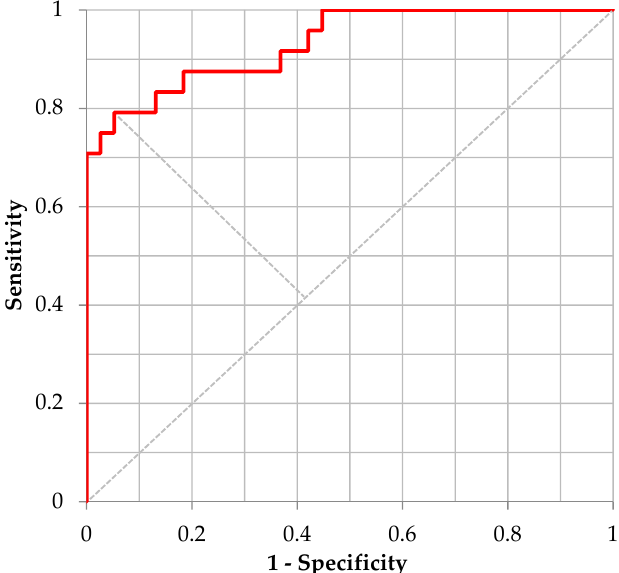
Figure 4. ROC curve for /Ah/+/Eh/+/Uh/.